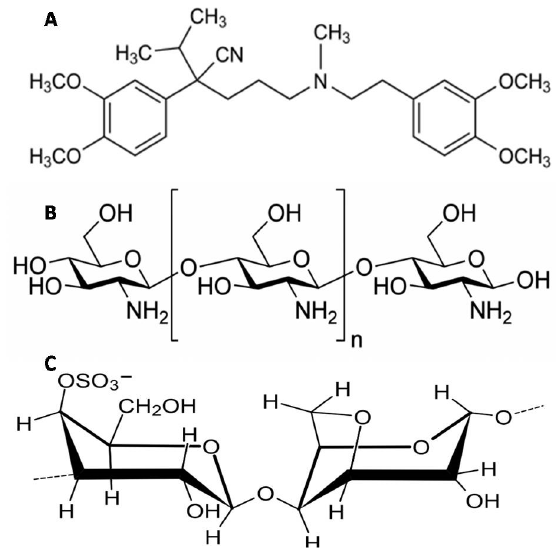
Figure 1. Chemical structures of ( A ) verapamil hydrochloride (VP); ( B ) Ch and ( C ) Kc.